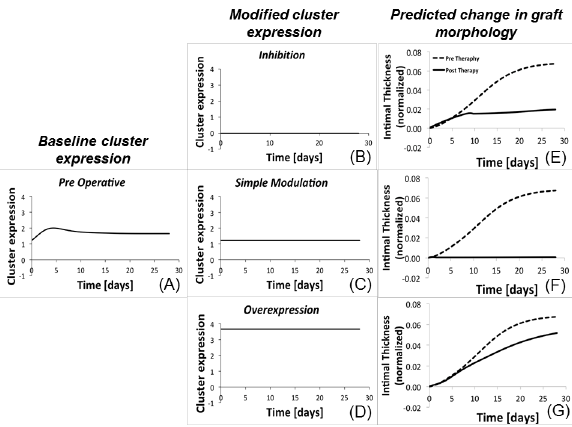
Fig 8. Gene therapy general concept. With the current analysis, a cluster dynamic (A), is modulated from its initial conditionin three distinct ways: completeinhibitionof cluster expression(B), freezing cluster expression at the initial (baseline)condition(C), and fixed overexpression of the cluster expression(D). The modification in cluster expressionalters the cell or ECM kinetics, leadinga new trajectory for hyperplastic growth of the wall (E)-(G). Dashedline represents the dynamic in absenceof therapy and the solid line, the dynamic post-